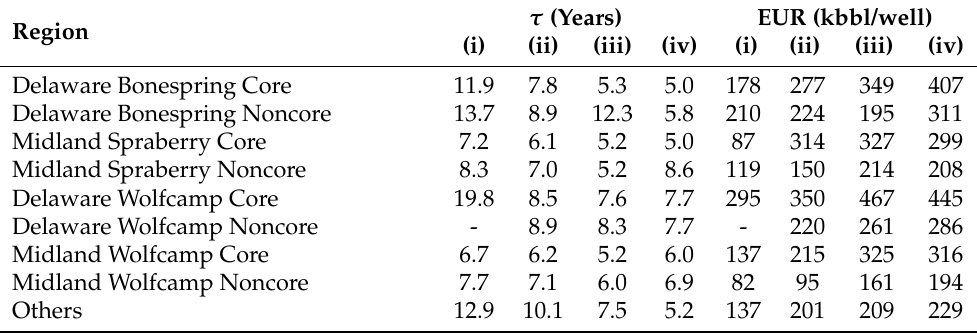
Table 1. The fitted values of τ ’s and EUR’s for each well cohort. Note that each roman number represents different completion date intervals: (i). 2008–2013, (ii). 2014–2015, (iii). 2016–2017, (iv). 2018–2021.